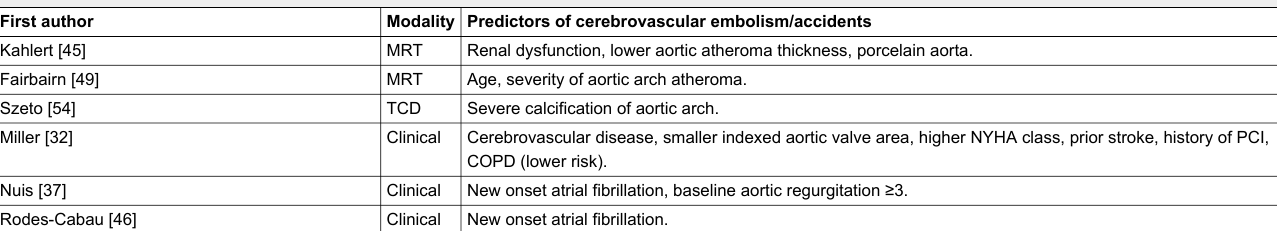
Table 1: Predictors of cerebrovascular embolism/accidents after